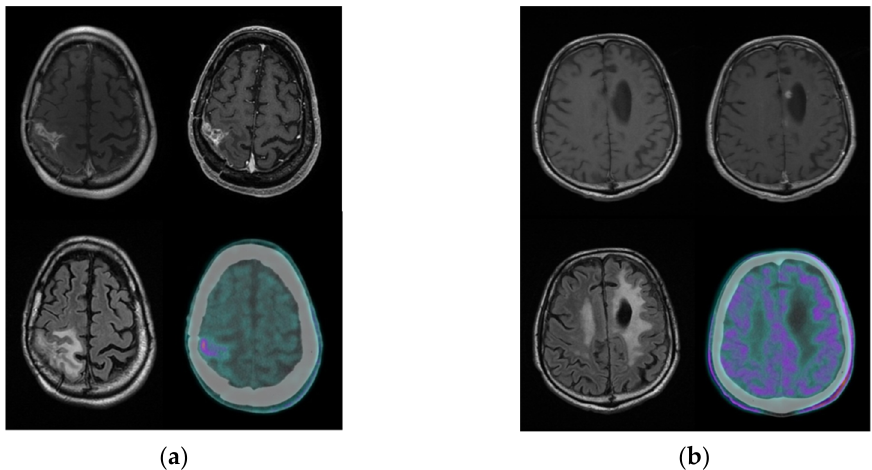
Figure 4. Representative examples of two patients with previous history of surgically treated grade IV HGG investigated with MET-PET scan for a suspicion of recurrence (T1-weighted, contrast-enhanced T1-weighted and FLAIR MR images and MET-PET images). In patient ( a ), MET-PET shows focal uptake higher than background in the right fronto-parietal region, corresponding to the site of abnormal signal intensity detected on MR and suspected for relapse; the T/B and SUVmax TTP values were 3.94 and 15.58, respectively. Recurrence was confirmed by surgery 1 month after MET-PET evaluation, and the patient died 10 months later. In patient ( b ), the MET-PET scan did not show any area of focal uptake higher than background, especially in the area of abnormal signal intensity detected at MR on the left medial paratrigonal region and suspected for relapse; the T/B and SUVmax TTP values were 1.45 and 8.64, respectively. The patient had no recurrence and was still alive at the time of the last follow-up.